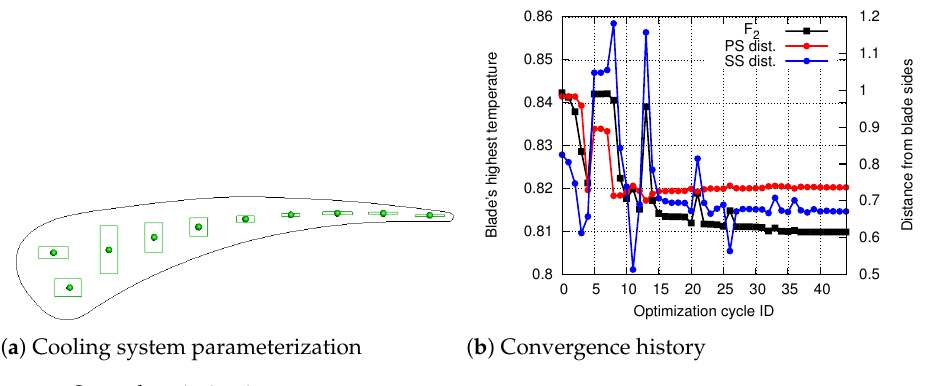
Figure 7. Second optimization